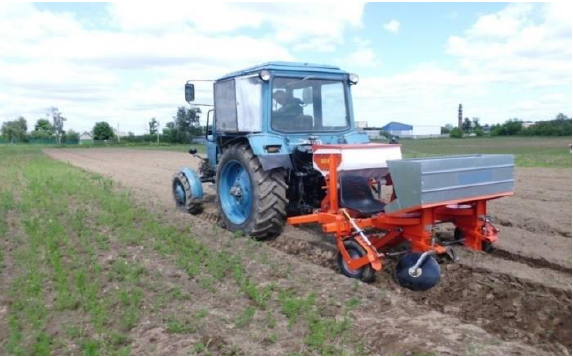
Figure 3. General view of a planting unit.